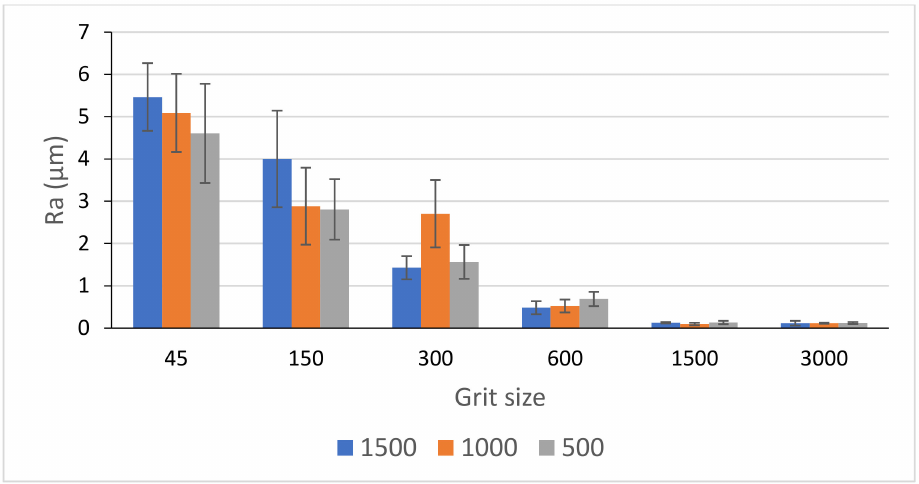
Figure 27. Ra-values of black granite depending on the grit size for different feed rates and fixed Vs = 2500